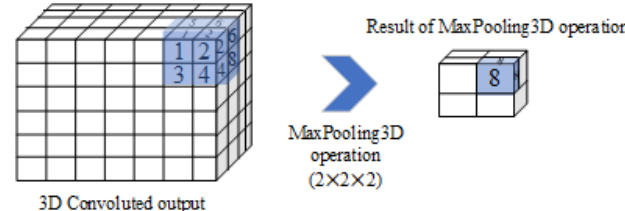
Figure 2. MaxPooling3D operation in the 3DCNN architecture